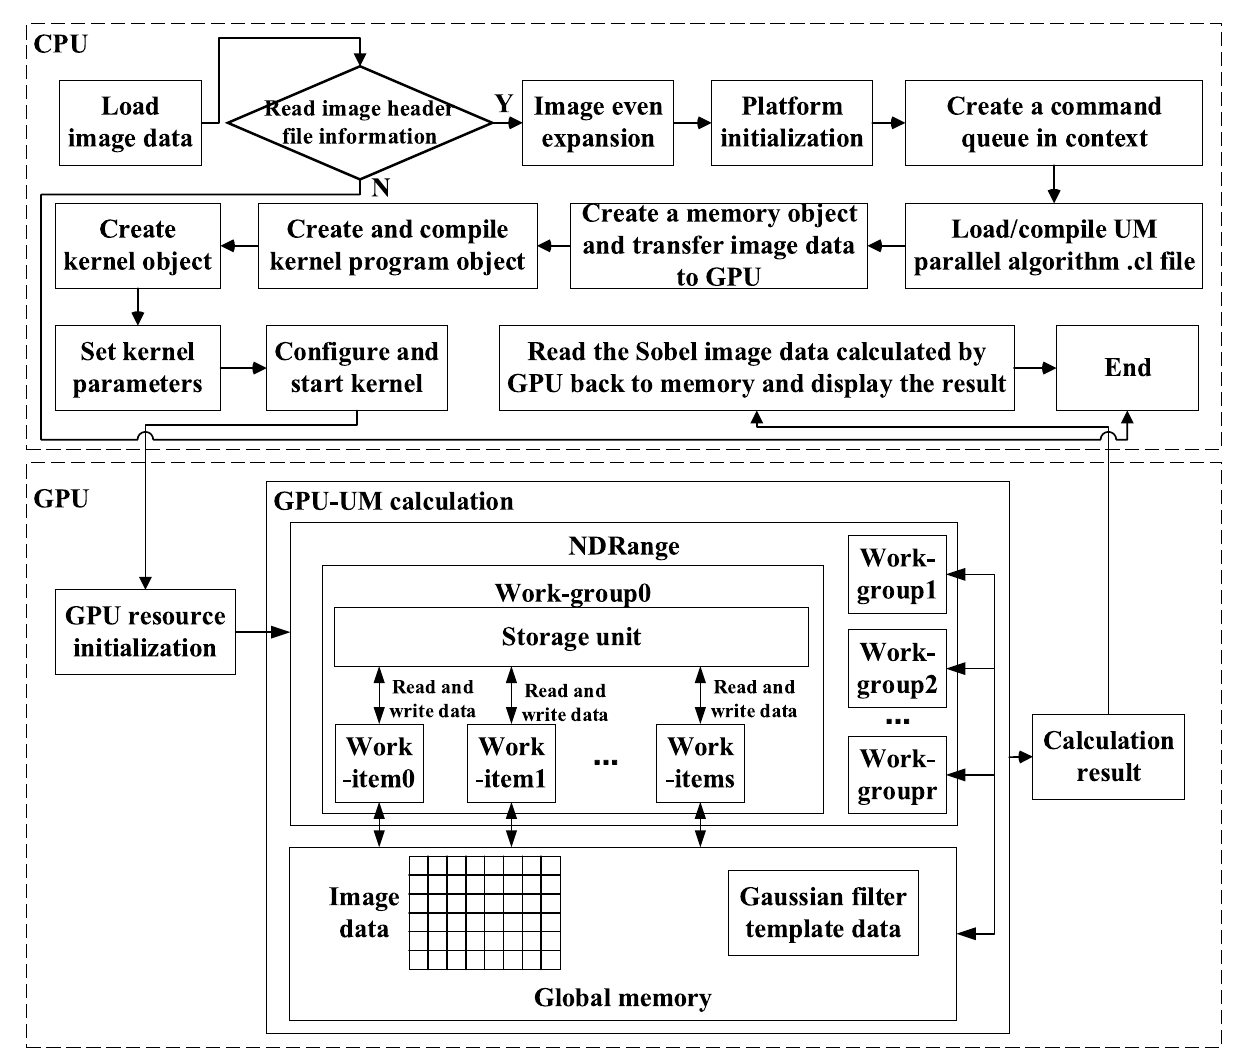
Figure 3. Parallel computing step diagram of the UM image enhancement based on